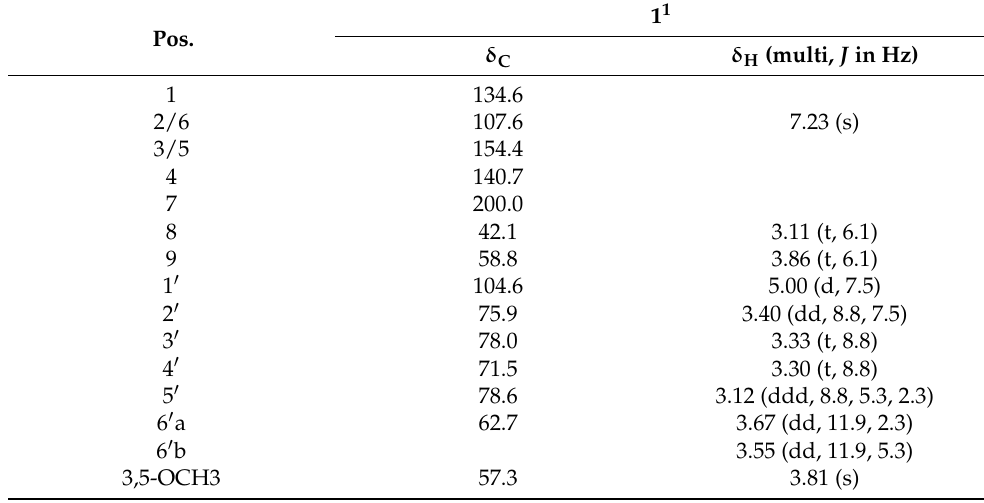
Table 2. 1 H (700 MHz) and 13 C (175 MHz) NMR data of compound 11 in methanol- d